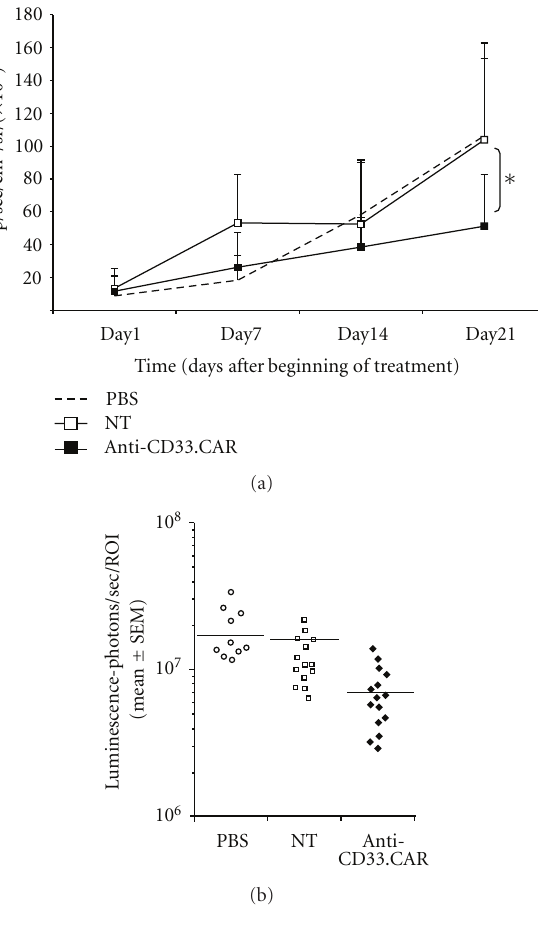
Figure 5: In vivo activity of anti-CD33.CAR-transduced EBV- CTLs against AML10. NOD/SCID mice were subcutaneously injected with ff LUC+AML10 cells, and after 5 days mice were weekly intravenously injected with either PBS, unmanipulated or anti-CD33.CAR-transduced EBV-CTLs. (a) Tumor volume was monitored weekly after D-luciferin injection using a Living Image software and was quantified as total photon flux normalized for exposure time and surface area and expressed in units of photons (p) per second per cm 2 per steradian (sr). Data shown are mean ± SD of 8 mice/group; ∗ P ≤ 0 . 05. (b) Intensity signals were log- transformed and summarized using mean ± SD at baseline and multiple subsequent time points for each group of mice. Changes in intensity of signal from baseline at each time point were